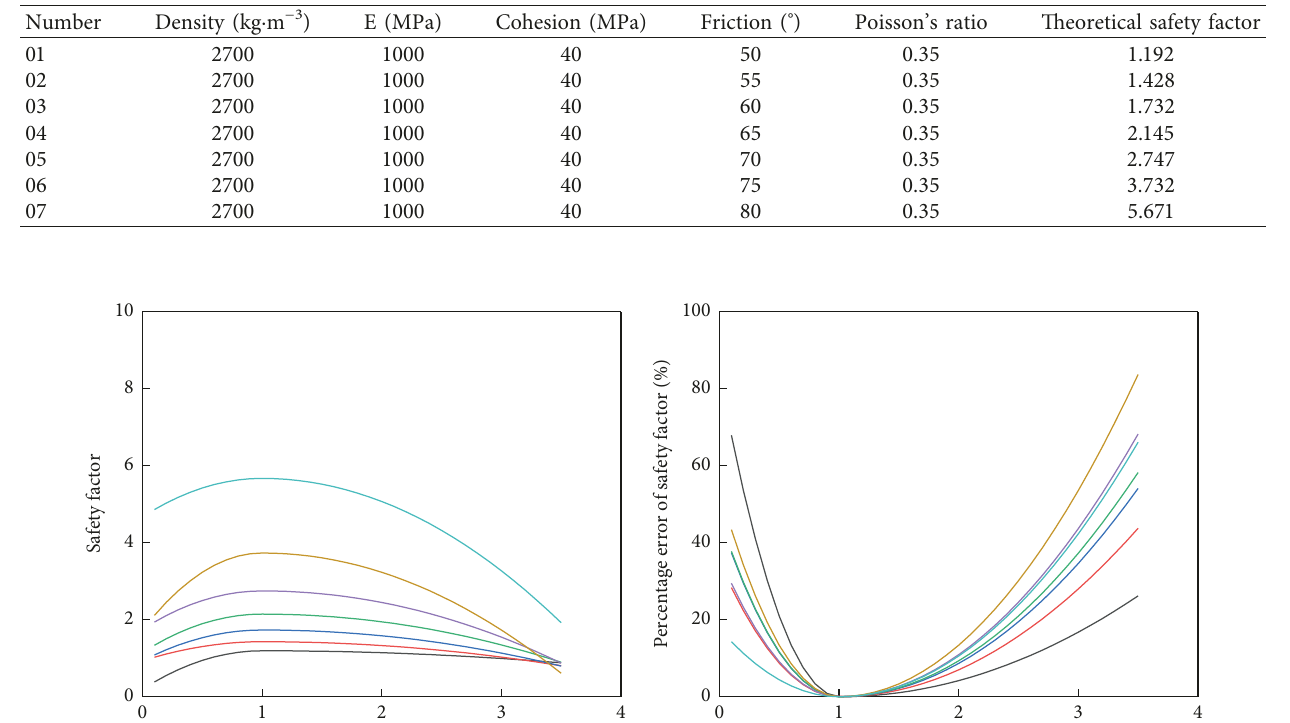
Table 1: Mechanical properties of the slope model.